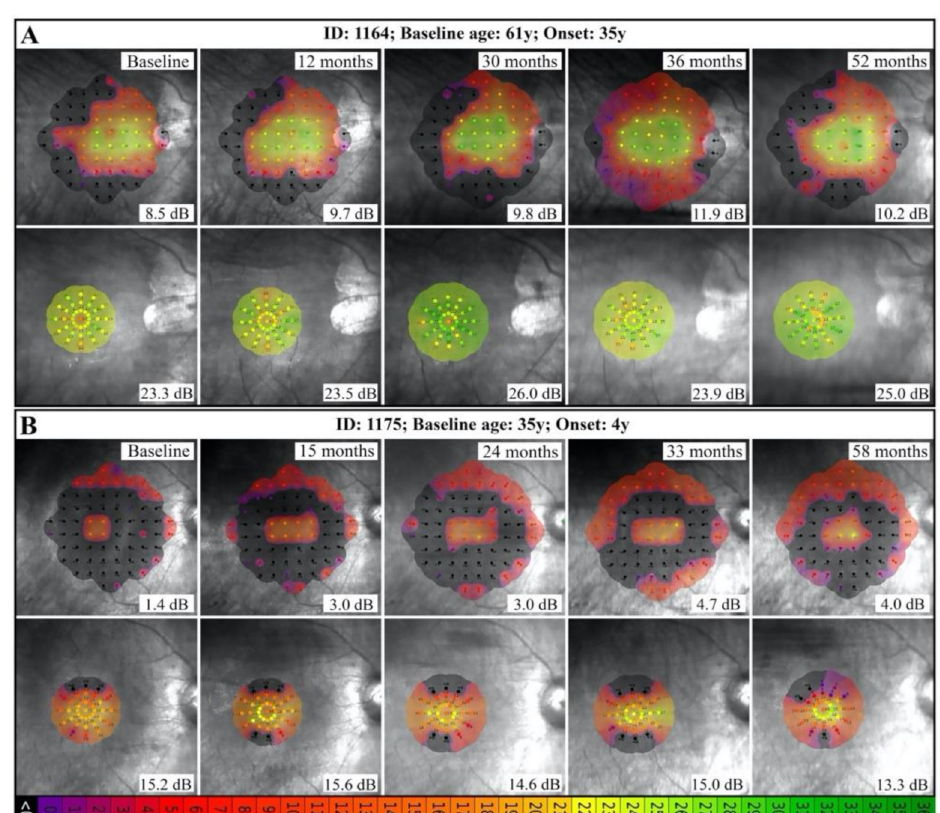
Figure 5. Serial 10-2 (macular) and 37R (foveal) MAIA in 2 patients with large deletions show short-term variation and long-term stability. Interestingly, the 61-year-old patient with adult-onset disease ( A ) had remarkably greater foveal and macular function compared to the 35-year-old patient with childhood-onset disease ( B ). Mean sensitivities are shown on bottom-right corner of each